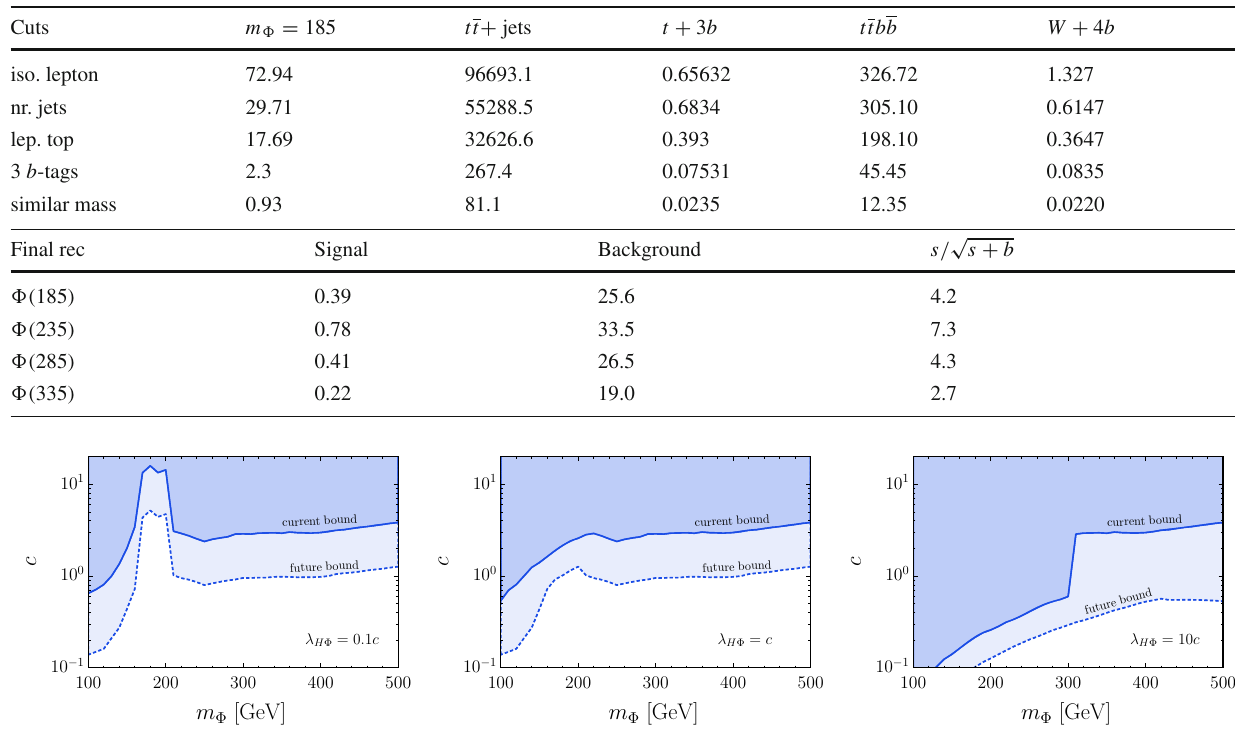
Fig. 12 Current (solid) and futute (dashed) bounds on the plane ( m (cid:2) , c ) for λ H (cid:2) = 0 . 1 c (left), λ H (cid:2) = c (center) and λ H (cid:2) = 10 c (right) and f = 1